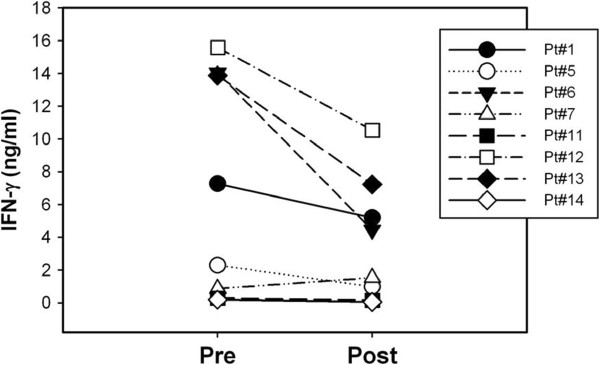
IFŇγ production by peripheral blood lymphocytes analyzed ex vivo. PBMC obtained pre-treatment and during week 7 of therapy were analyzed for T cell function by stimulating with the superantigen SEA and measuring IFN-γ production by ELISA. The post-versus pre-treatment values for the group of samples were statistically different as measured using a paired t-test (p<0.05).